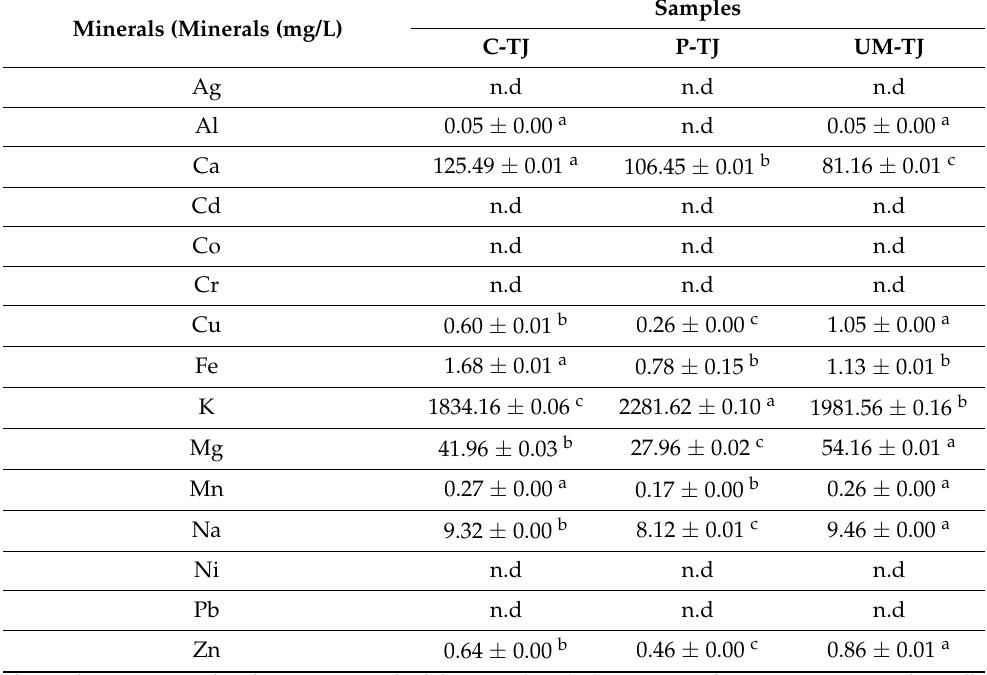
Table 6. Effects of C-TJ, P-TJ, and UM-TJ on minerals (mg/L). Minerals (Minerals